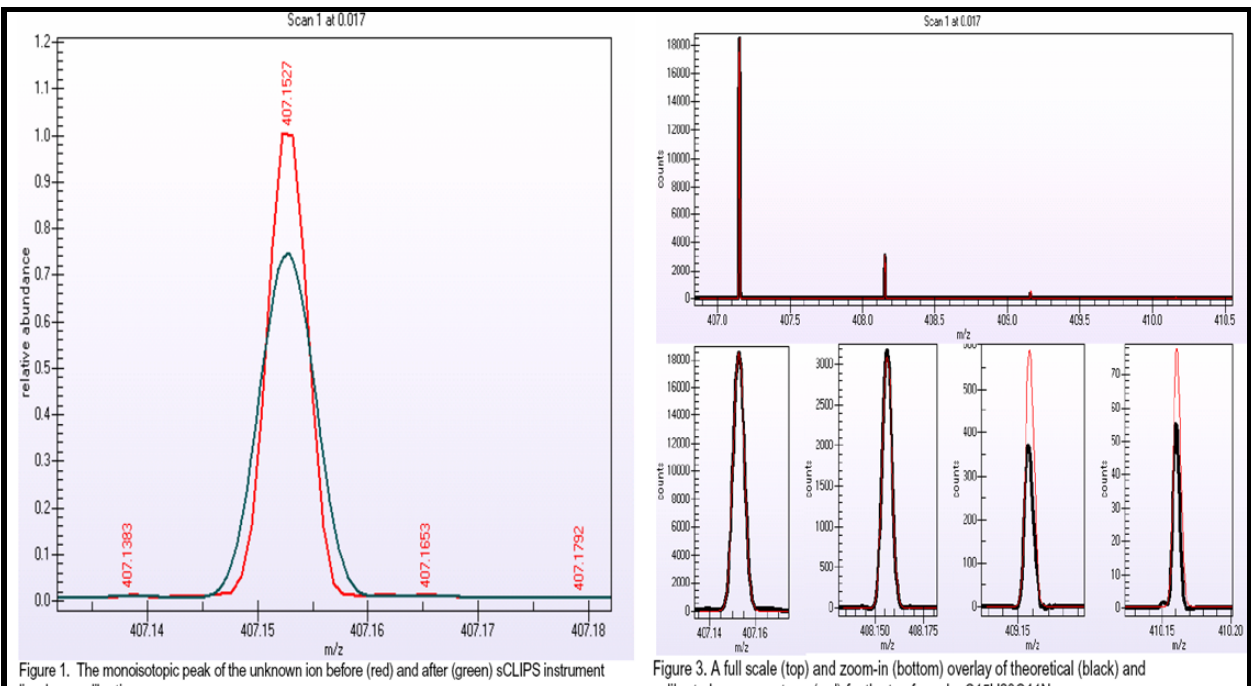
Figure 14. The unique elemental composition of m/z 407.1527 was assigned as C H O Na using Mass Works TM based on LC-MS data acquired using UPLC LTQ FT 15 28 11 Ultra MS at 100,000